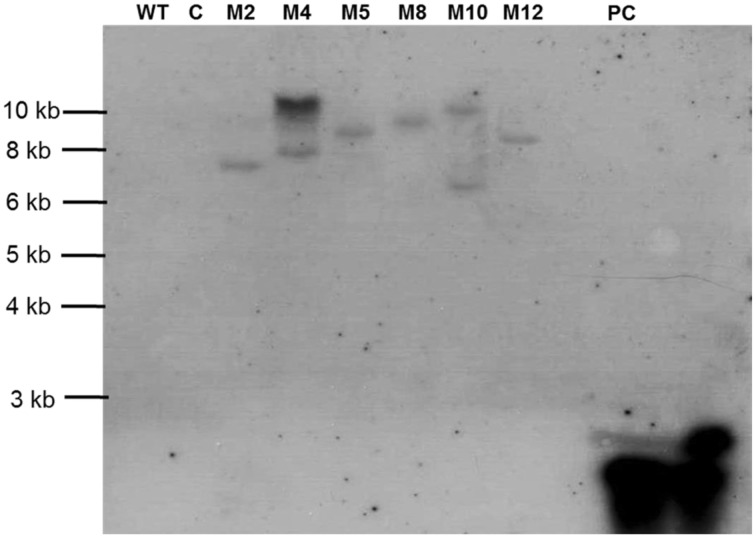
Southern blot for transgenic tomato harboring dsRNA of Mi-cpl-1. Lines used include Tomato “Pusa Ruby” wild type (WT), transgenic empty pHELLSGATE12 vector control (C) and transgenic pHELLSGATE12-Mi-cpl-1 (M2, M4, M5, M8, M10, M12). Probe Mi-cpl-1 (PC) was used for the hybridization.